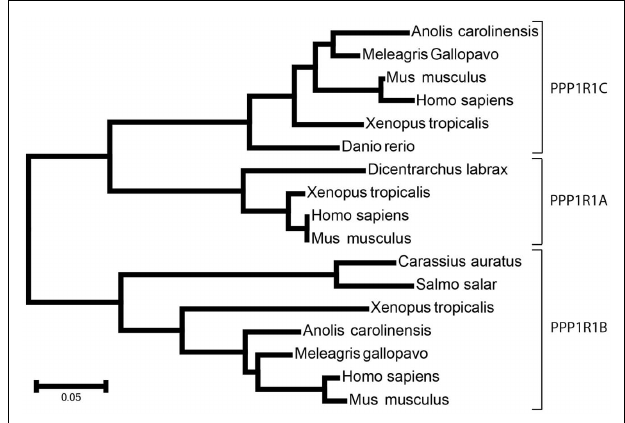
FIGURE 2 | Phylogeny of PPP1R1 family. The evolutionary history was inferred using the Neighbor-Joining method (Saitou and Nei, 1987).The optimal tree with the sum of branch lengths = 1.395 is shown.The tree is drawn to scale, with branch lengths in the same units as the evolutionary distances used to infer the phylogenetic tree (number of amino acid differences per site).The evolutionary distances were computed using the p-distance method (Nei and Kumar, 2000). Positions containing gaps and missing data were eliminated.There were a total of 42 positions in the final dataset. Evolutionary analyses were conducted in MEGA5 (Tamura et al., 2011).The 17-amino acid sequences analyzed were: PPP1R1A